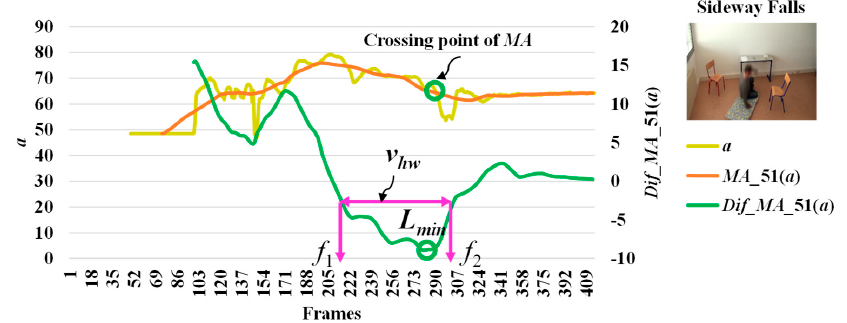
Figure 5. Analysis for a high possibility of abnormal (falling) points based on the area of the object shape ( a ) by falling sideways.